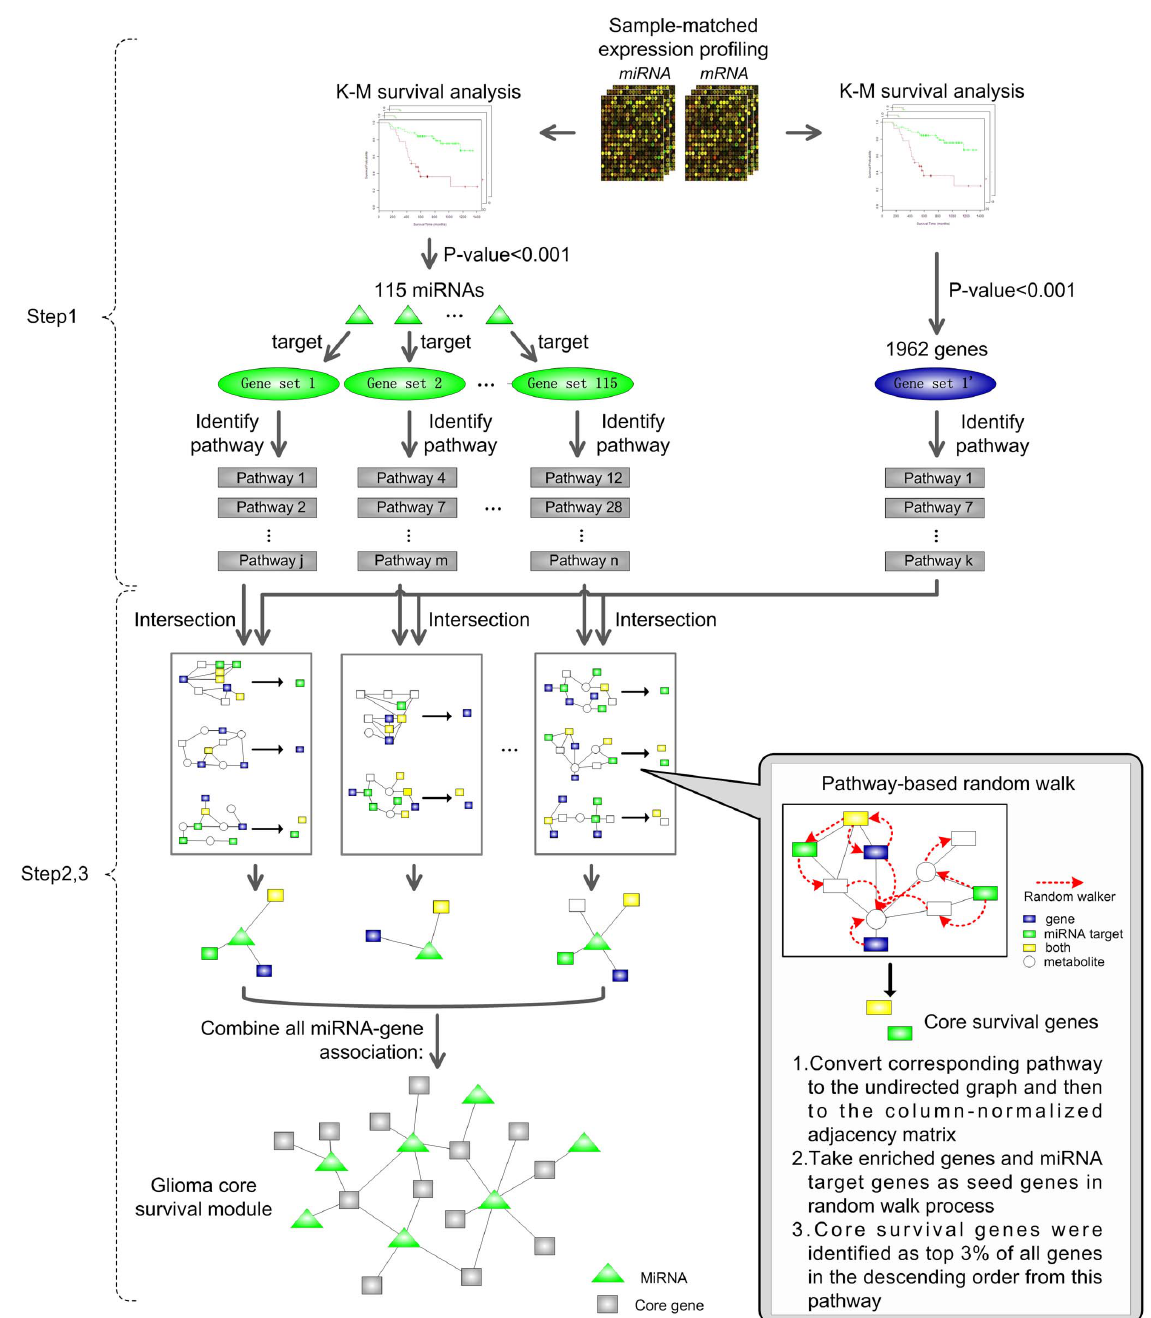
Figure 1. Workflow overview. We identified a glioma core survival module based on sample-matched miRNA, mRNA expression and pathways structure. First, we utilized Kaplan-Meier (K-M) survival analysis to identify glioma survival related miRNAs and genes. Then, we integrated these miRNAs and genes to further identify KEGG pathways. Finally, we developed a pathway-based random walk method to identify glioma core survival genes from each pathway, and constructed a glioma core miRNA-gene survival module. tumor. Detailed information concerning the 14 glioma survival related pathways is given in Table S2.